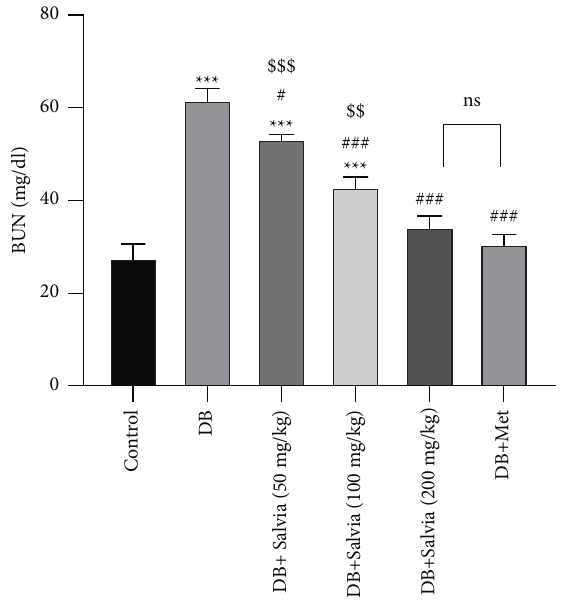
Figure 3: Effect of Salvia spinosa extracts on blood urea nitrogen (BUN) concentrations in streptozotocin-induced diabetic mice. Control: normal mice, DB: diabetic mice, DB+Salvia: diabetic mice given the methanolic extract of Salvia spinosa , and DB+Met: dia- betic mice given metformin (500mg/kg). Values represented as mean ± SD. ∗∗∗ P < 0 . 001 compared with control mice. # P < 0 . 05 compared with diabetic mice. ## P < 0 . 01 compared with diabetic mice. ### P < 0 . 001 compared with diabetic mice. $$ P < 0 . 01 com- pared with metformin-treated diabetic mice. $$$ P < 0 . 05 compared with metformin-treated diabetic mice. Ns: nonsignificant.